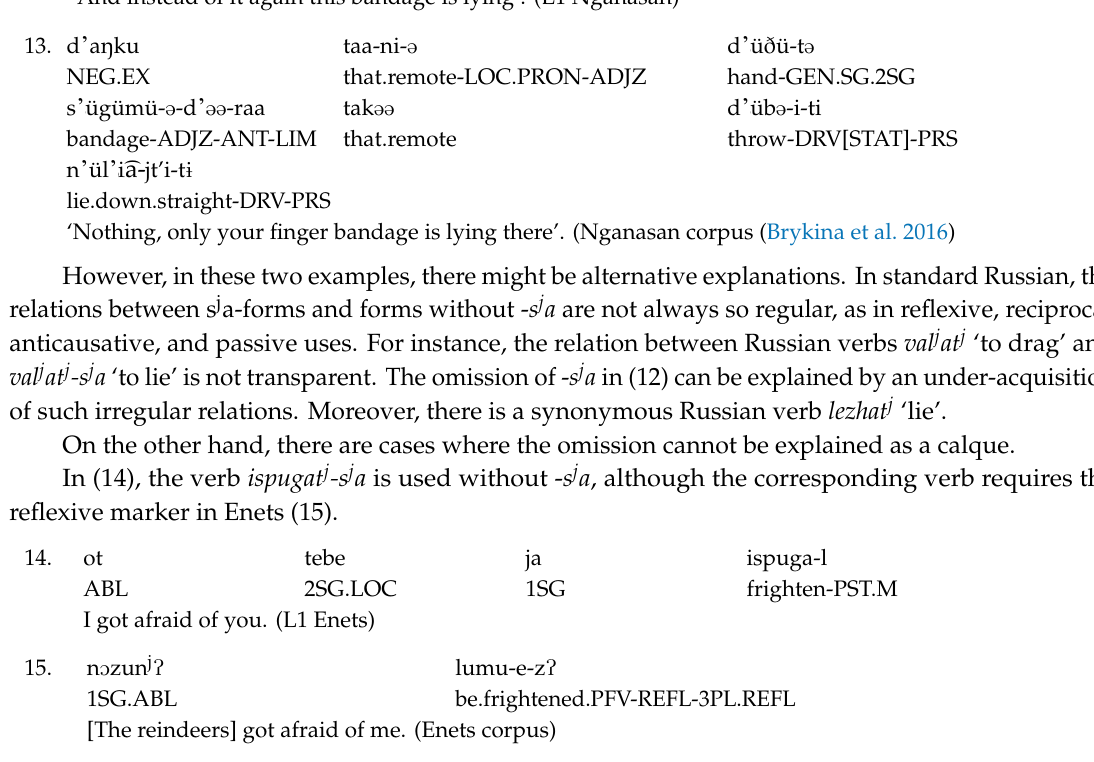
Table 2. Overuses vs. omissions of - s j a .